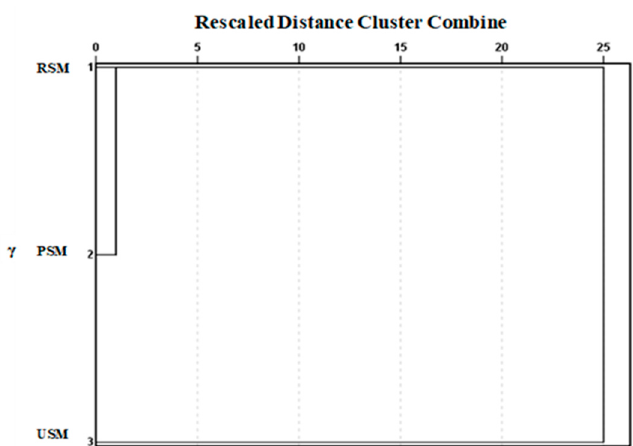
Figure 1. Cluster analysis (CA) of the sensory evaluation for three different skim milk samples. RSM, skim milk obtained by centrifugation of raw milk; PSM, skim milk obtained by centrifugation of raw milk after preheating treatment at 85 °C, 15 s; USM, skim milk obtained by centrifugation of raw milk after preheating treatment at 137–141 °C, 4 s.